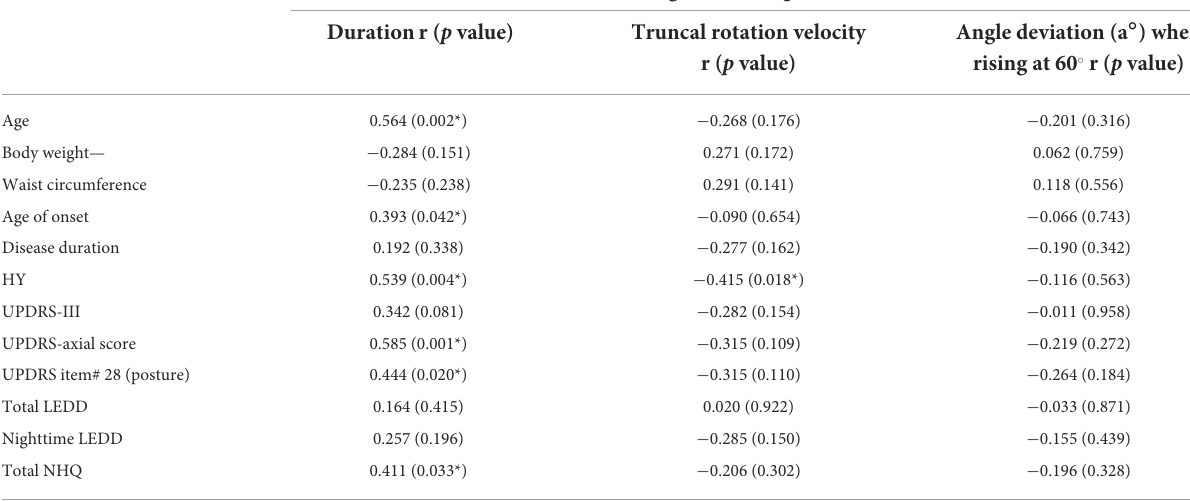
TABLE 3 Correlation analysis between getting out of bed parameters and clinical characteristics of patients with Parkinson’s disease. Clinical